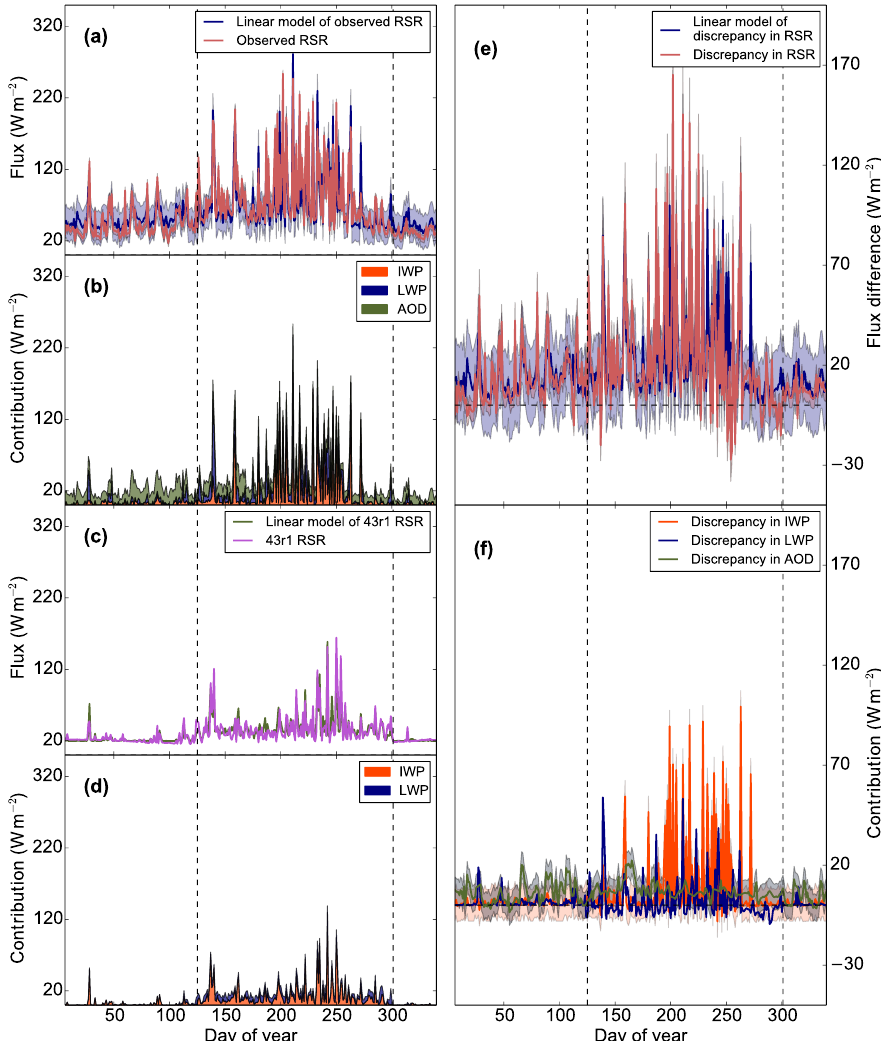
Figure 10. The same as Fig. 7 but for reflected shortwave radiation at the TOA, with observation–43r1 linear model contributions from IWP (orange), LWP (blue) and (observations only) AOD (green) in plots (b) and (d) , and discrepancy model contributions from IWP (orange), LWP (blue) and AOD (green) in plot (f)